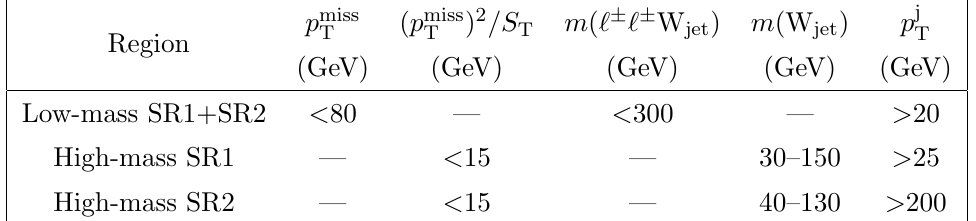
Table 1 . Selection requirements, after applying the preselection criteria, for the low- and high-mass signal regions. A dash indicates that the variable is not used in the